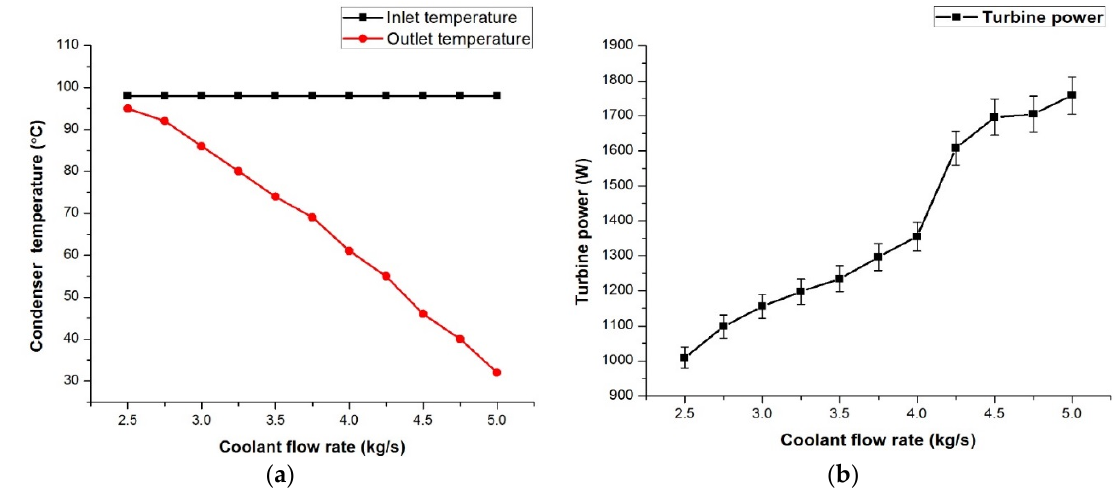
Figure 9. Variation of condenser temperature ( a ) and turbine power ( b ) with coolant flow rate.